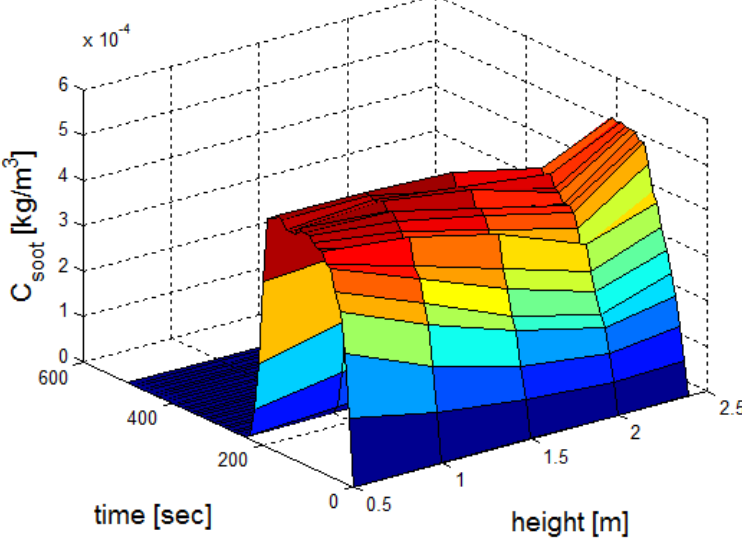
Figure 23. Three dimensional plot of the soot concentration field as a function of time and height.